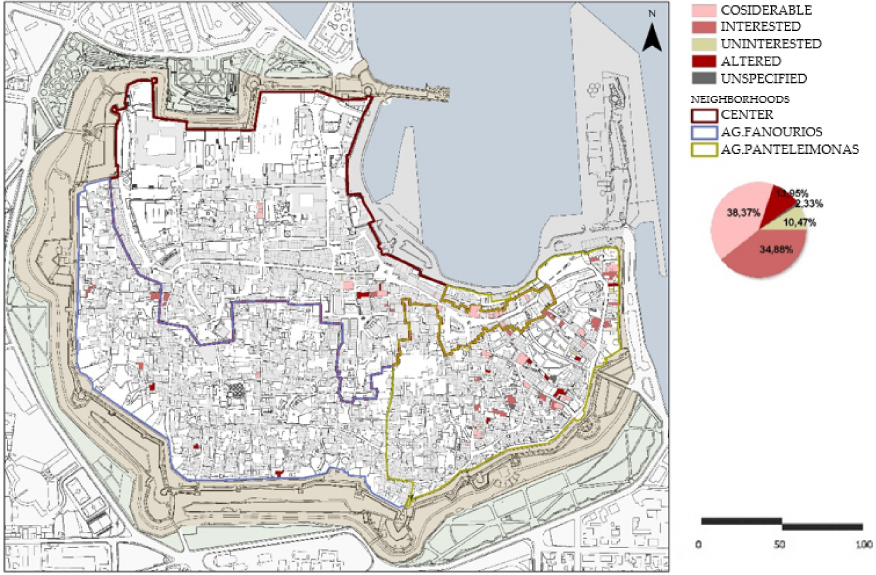
Figure 22. Evaluation of selected